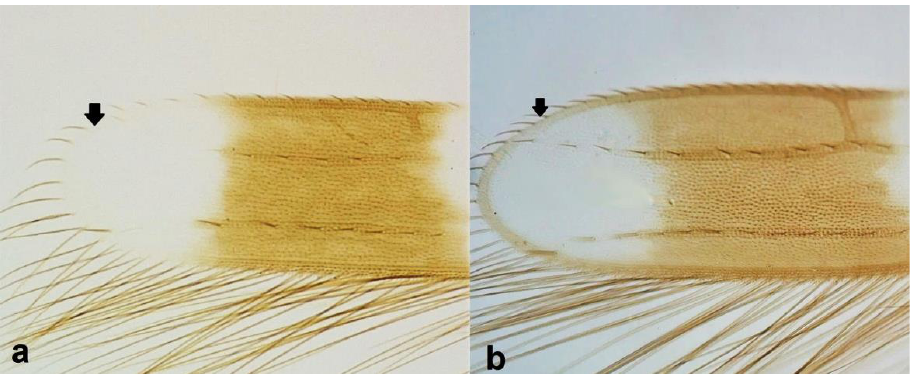
Figure 7. Fore wing: ( a ) pale coloured margin at tip; ( b ) dark coloured margin at tip.